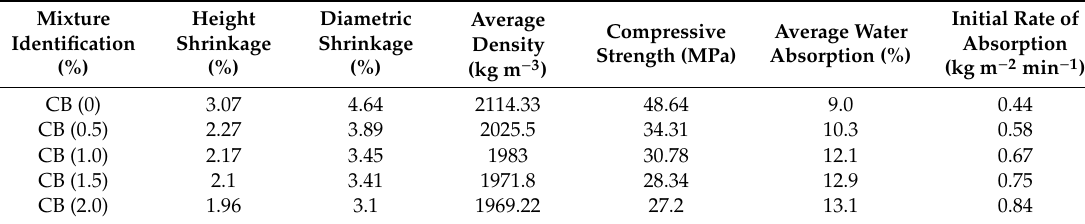
Table 2. Properties of brick samples with 0%, 0.5%, 1%, 1.5%, and 2% CB